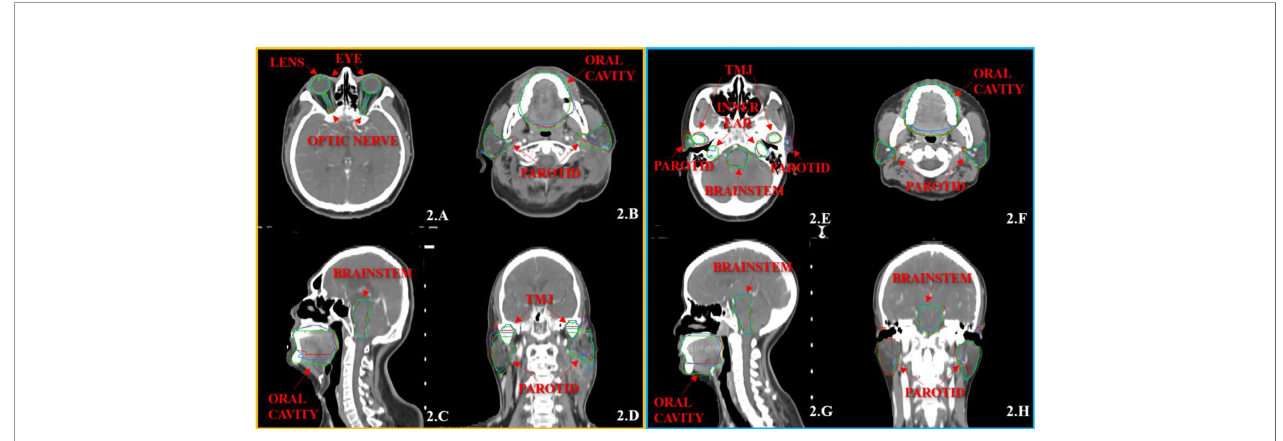
FIGURE 2 | The segmentation results on the pre-built and trained DL-based models for the two same cases with the transverse (A, B, E, F) , sagittal (C, G) , and coronal (D, H) images, respectively. The ground-truth delineations are depicted in red, the automatic delineations based on the pre-built DL-based model are depicted in green, and the automatic delineations based on the trained DL-based model are depicted in blue. Case 1 is shown in (A – D) , and case 2 is shown in (E – H)